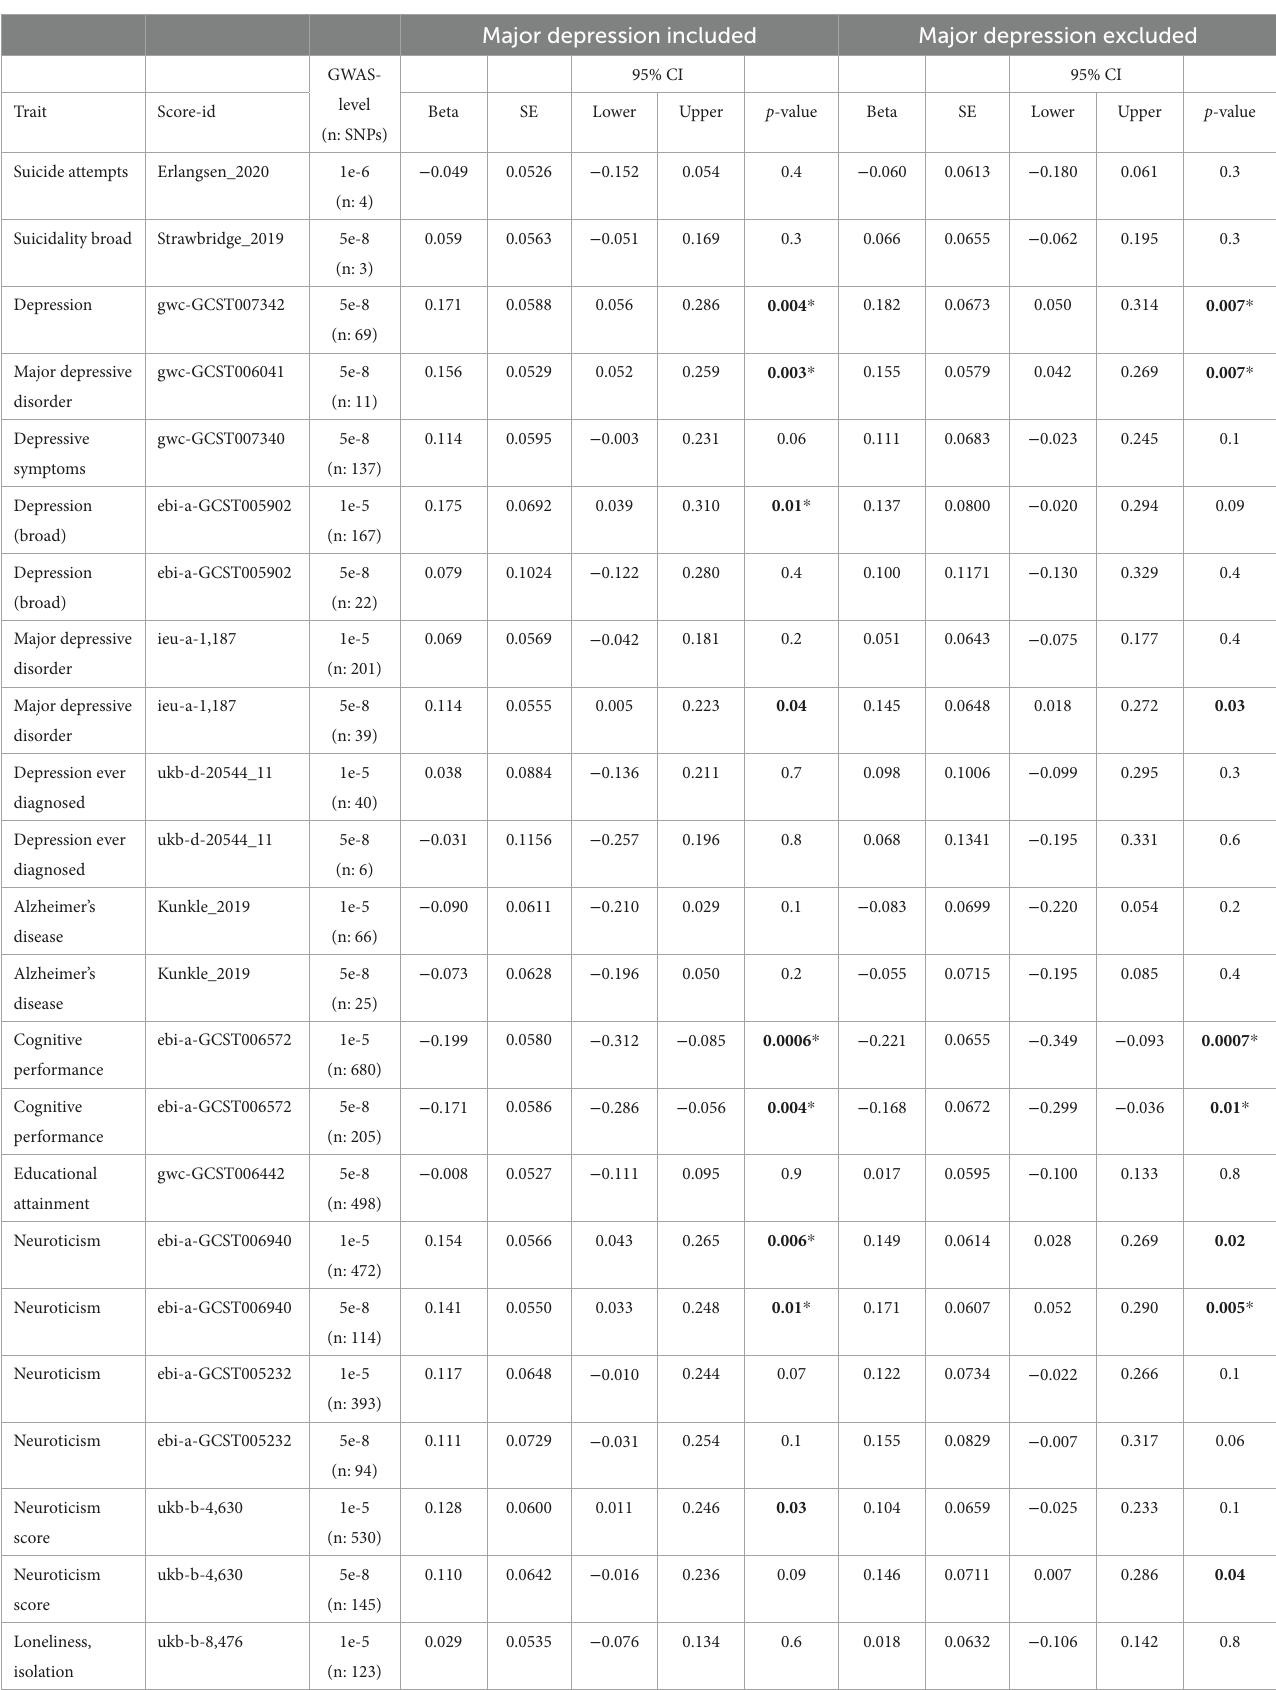
TABLE 2 Associations between polygenic risk scores and suicidal feelings in a population-based sample of older adults ( n = 3,019). Major depression included Major depression